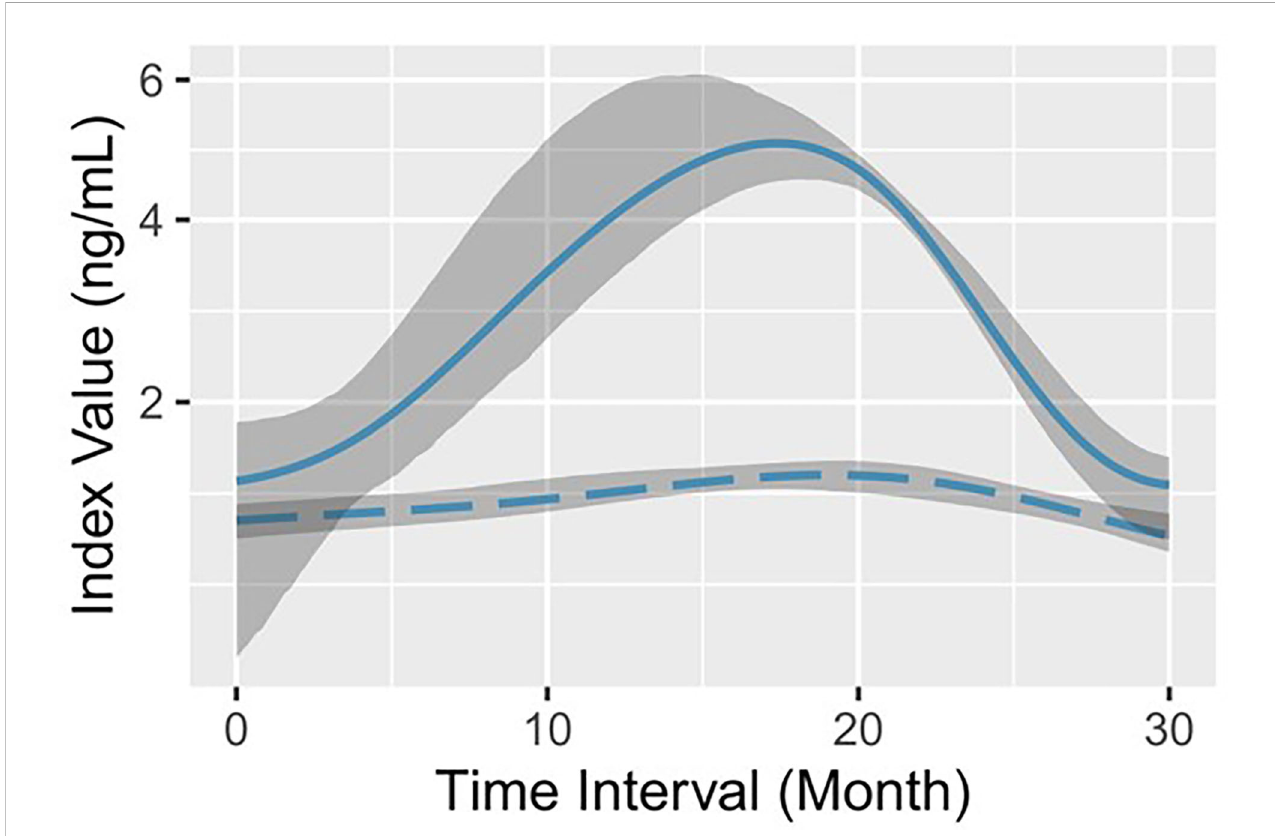
FIGURE 1 Log-predicted GAMs with 90% bootstrap pointwise con fi dence intervals for serum AFP. The solid line (representing remission) and the long-dashed line (representing progression) indicate the log- fi tted GAM of serum AFP in the remission group and the progression group, respectively. The shadow area corresponds to the 90% bootstrap resampling pointwise con fi dence